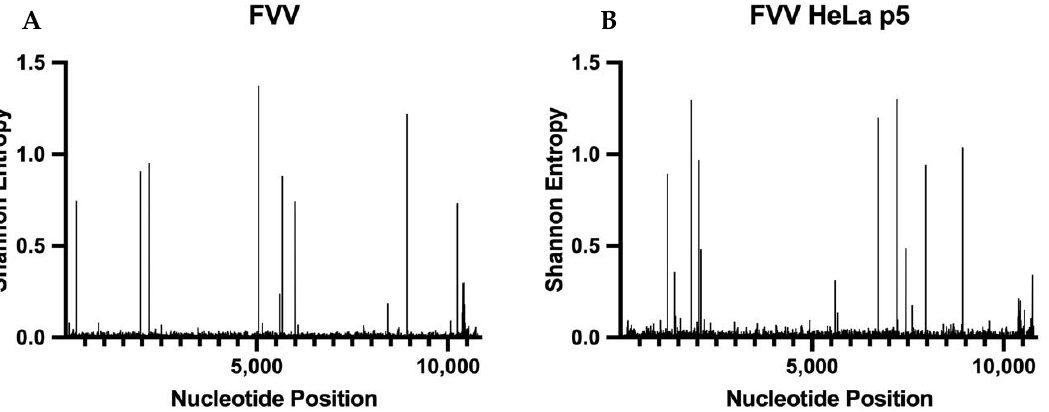
Figure 1. Shannon Entropy Values for FVV HeLa p5 ( A ) and FVV ( B ). FVV HeLa P5 displays statistically similar levels of Shannon Entropy compared to FVV.